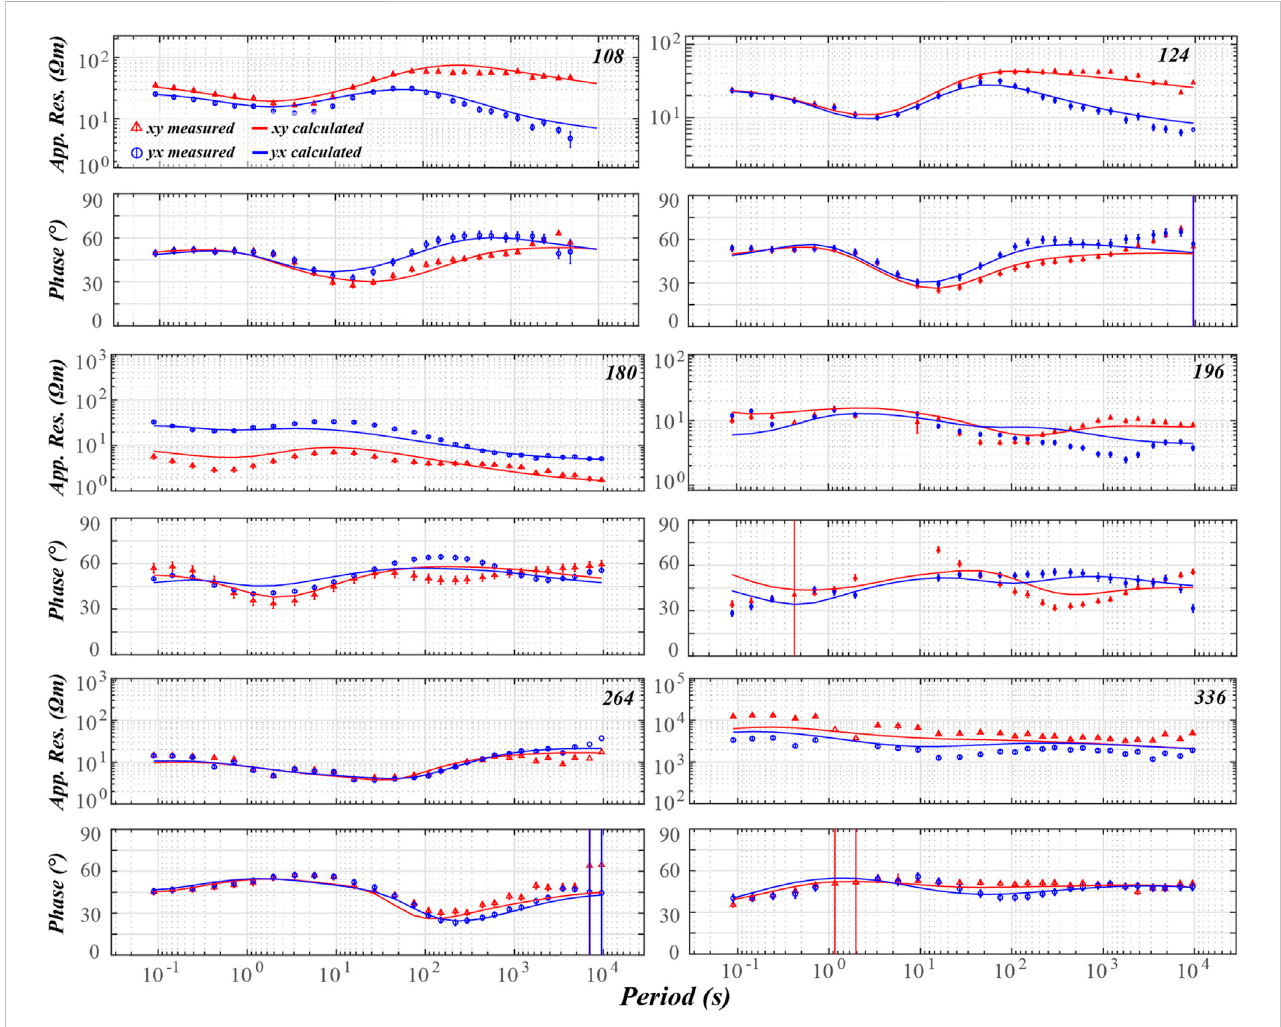
FIGURE 3 Sounding curves and model responses of xy and yx modes data at six stations with their names marked in Figure